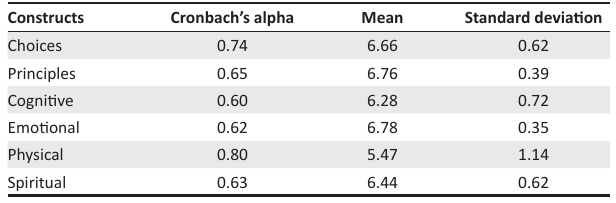
TABLE 7b : Model-fit and construct reliability